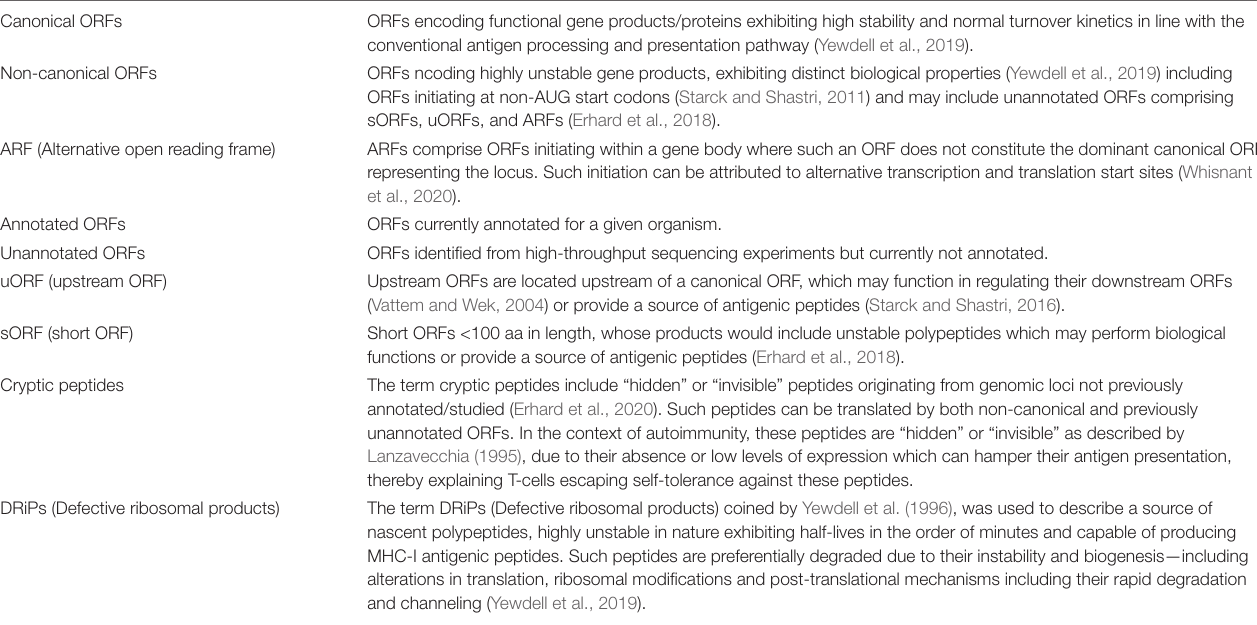
TABLE 1 | Glossary of terminologies representing the nature of peptides in this study. Canonical ORFs ORFs encoding functional gene products/proteins exhibiting high stability and normal turnover kinetics in line with the conventional antigen processing and presentation pathway (Yewdell et al.,